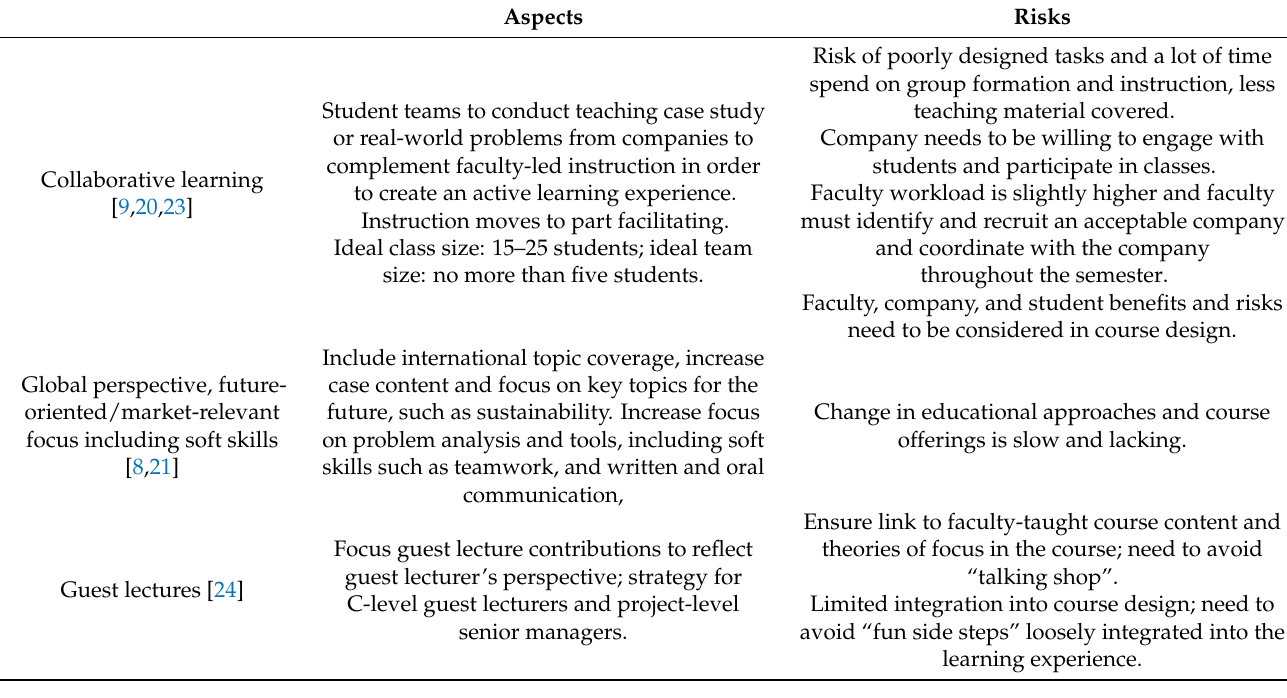
Table 1. Selected teaching design input from supply chain